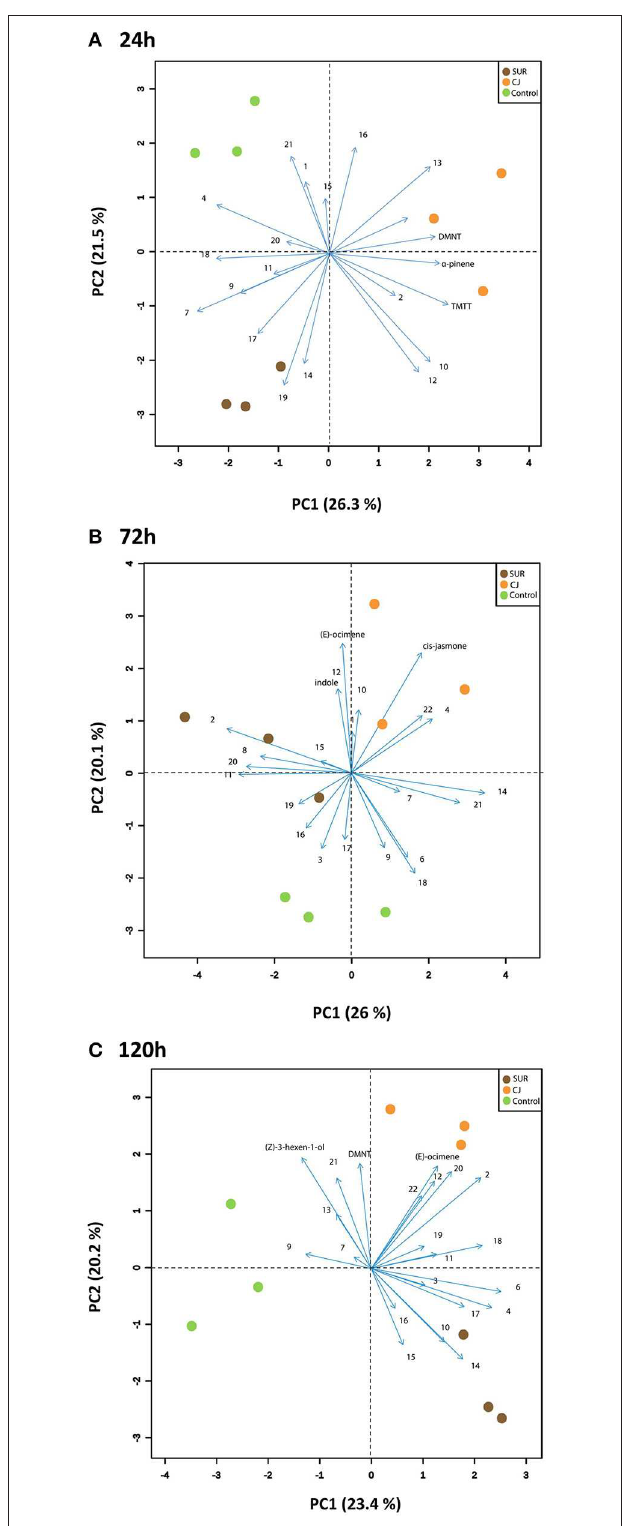
FIGURE 4 | Principal Component Analysis (PCA) of the volatile profiles produced from the different treated potato plants (i.e., Control, non-treated